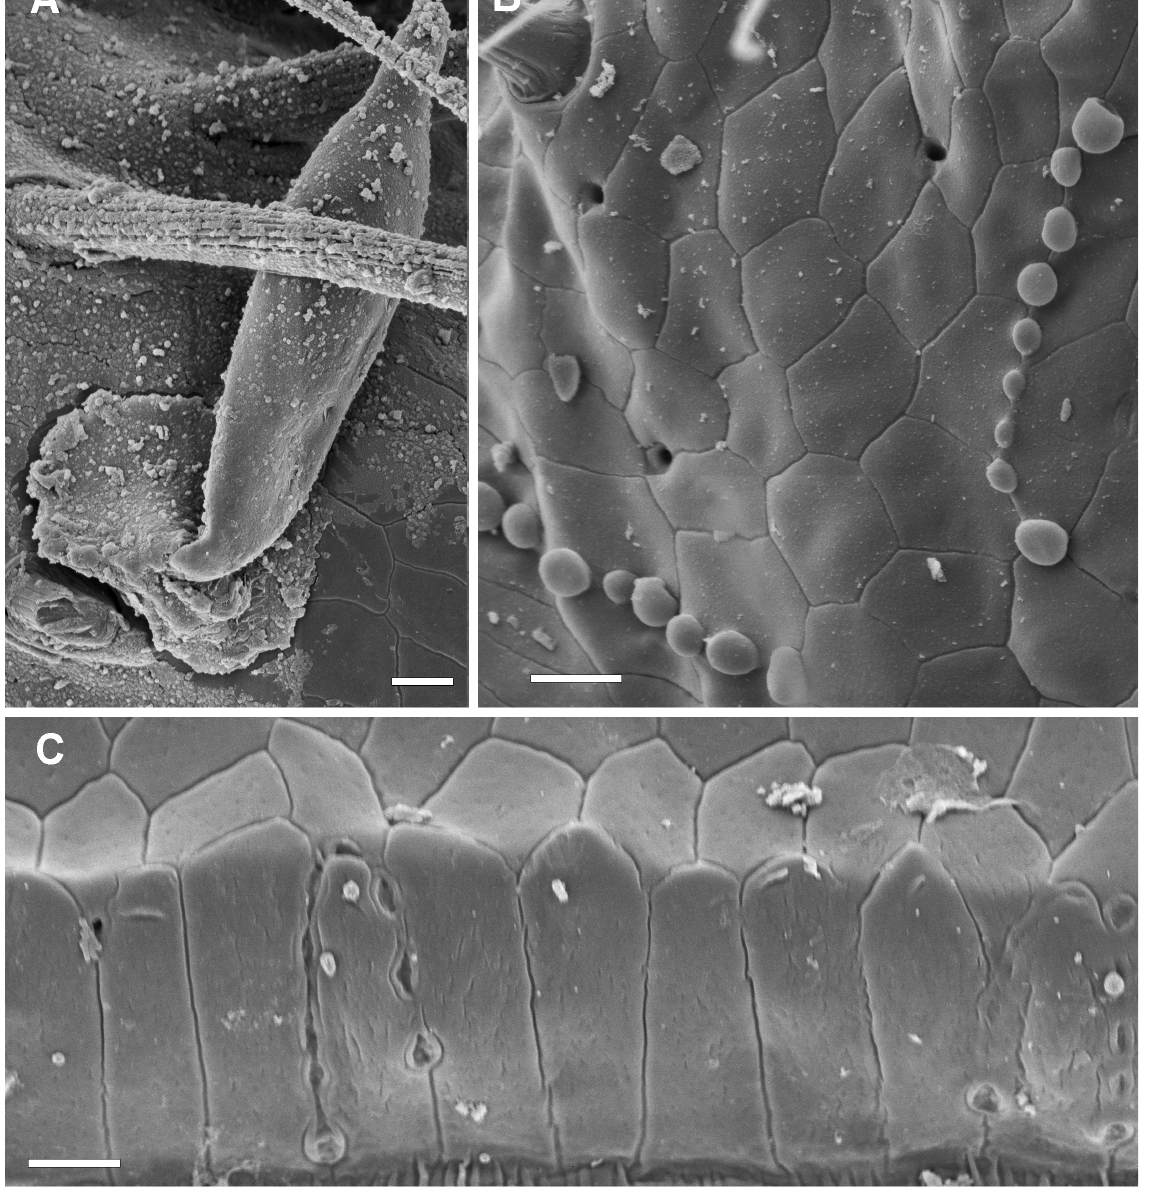
Fig. 40. Epizootic fungi on Eviulisoma spp. A . Basidiobolus Eidam on E. chitense sp. nov. B–C . Fungi? (ʻintercalary cuticular microscutesʼ) B. On E. chitense sp. nov. C. On E. biquintum sp. nov. Scale bars: 0.005